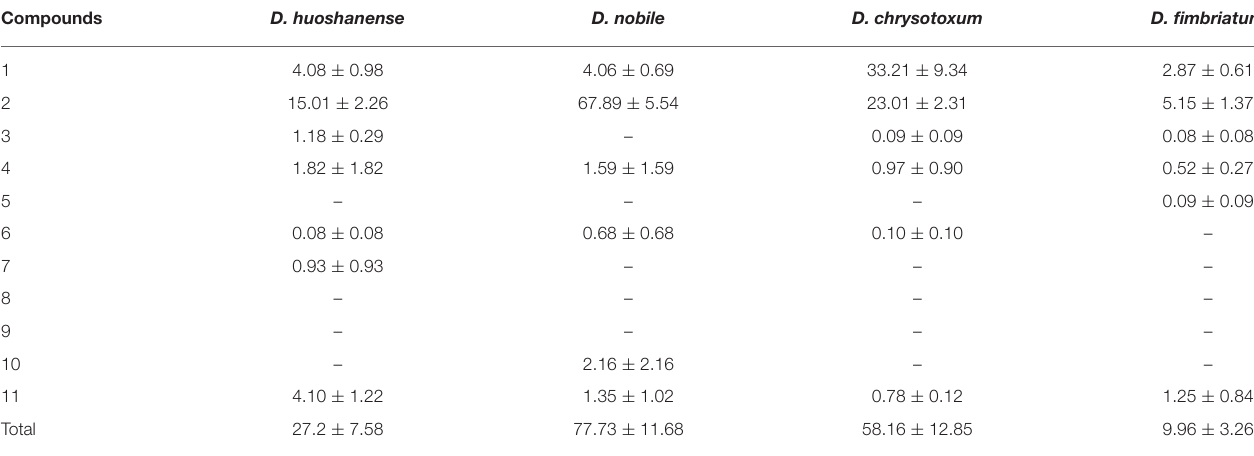
TABLE 5 | Quantification of 1–11 in the four Dendrobium species (mg/kg). Compounds